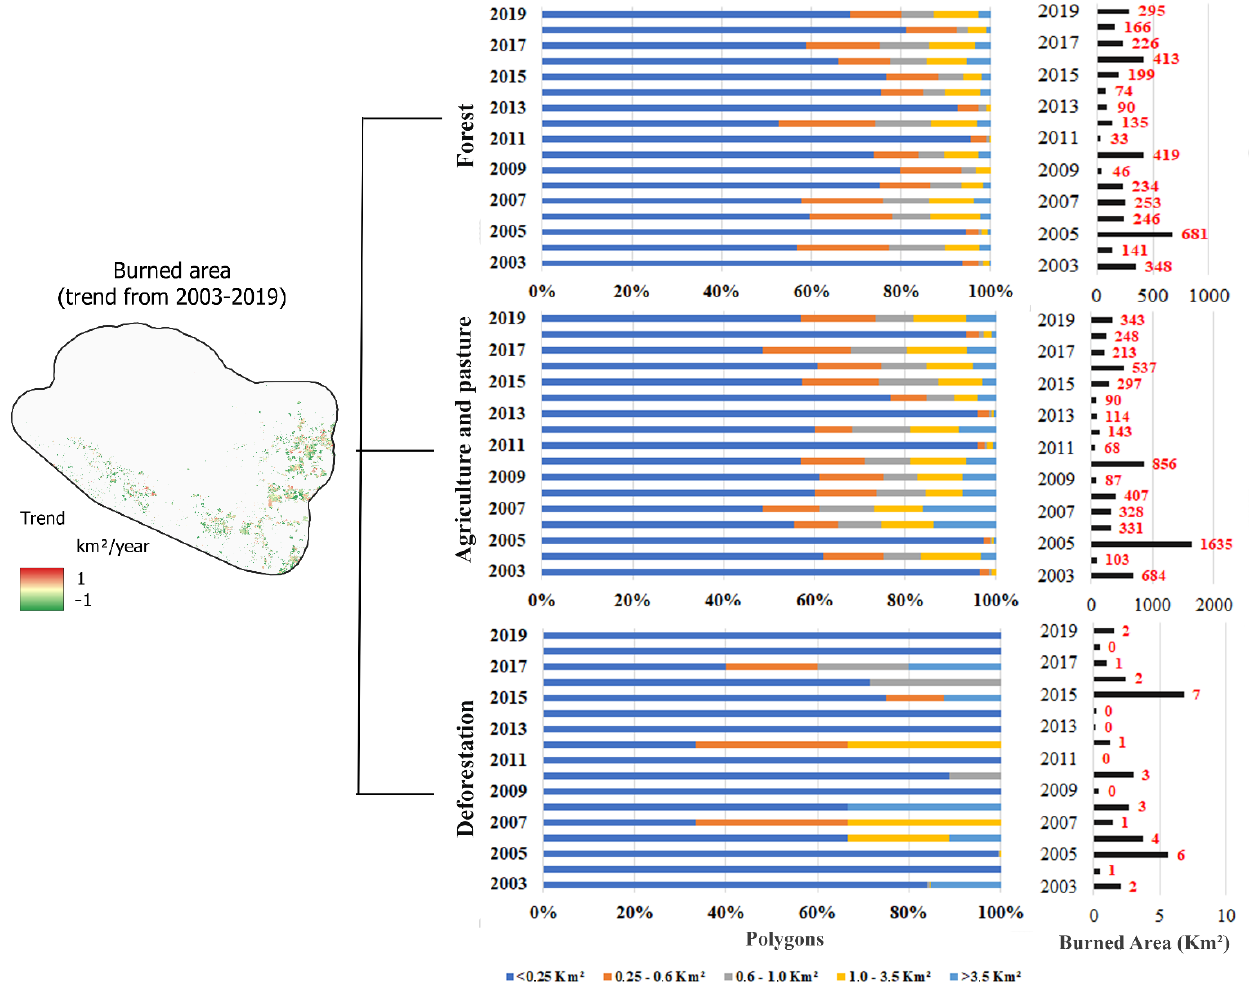
Figure 4. Spatial trends for each burned area (30 m spatial resolution) between 2003 and 2019, negative values (in green) represent a decreasing trend, while positive values (in red) represent an increasing trend. The variation in the burned area by land-use category from MapBiomas is shown. The graphs to the left show the relative burned area by burned-area size and the graphs to the right show the absolute burned area (km 2 ).